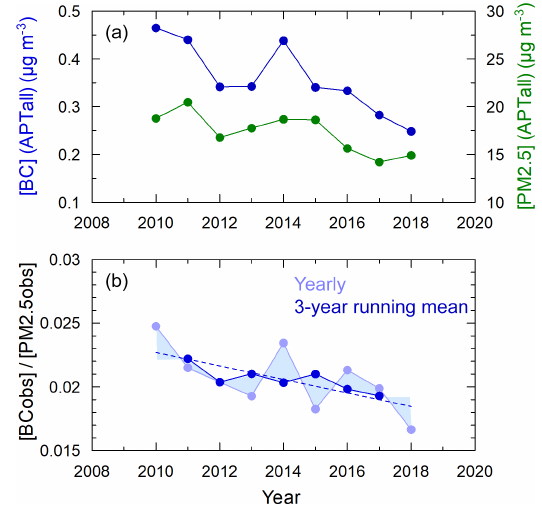
gions III (S-CEC) and IV (S China) with rates of ( − 6 . 9 ± 1 . 5) and ( − 9 . 6 ± 2 . 0) % yr − 1 , respectively (for all seasons). This pattern was quite comparable to the case of BC. In South Korea, the reduction in CO ( − 2 . 5 ± 1 . 5) % yr − 1 was rela- tively small when compared to BC ( − 9 . 3 ± 0 . 6) % yr − 1 . In Japan, the reduction ( − 3 . 8 ± 0 . 4) % yr − 1 was similar to BC ( − 4 . 4 ± 2 . 8) % yr − 1 .